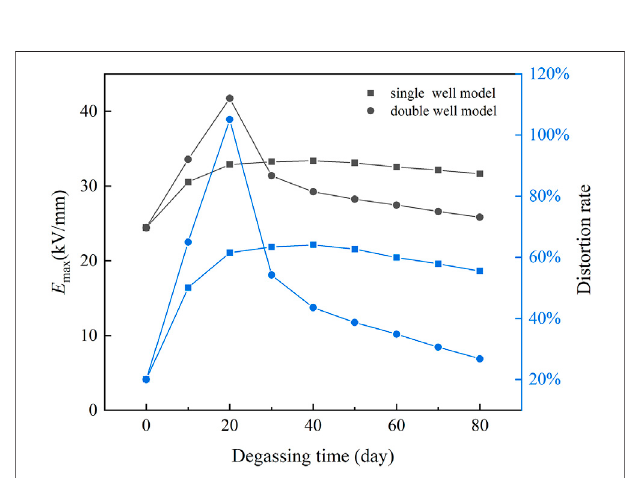
FIGURE9| E max anddistortionrateoftheelectric fi eldincableinsulation.